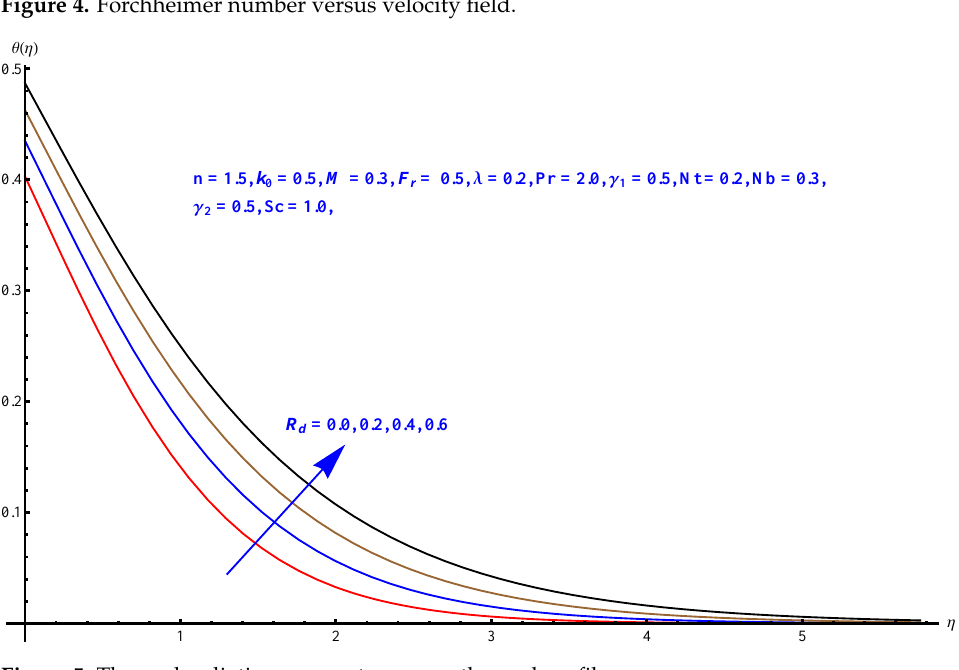
Figure 5. Thermal radiation parameter versus thermal